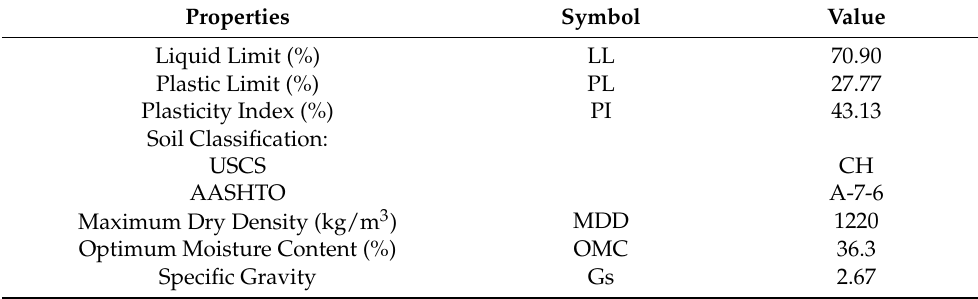
Figure 2. Grain size distribution of the untreated clay. Table 2. Physical characteristics of untreated clay.